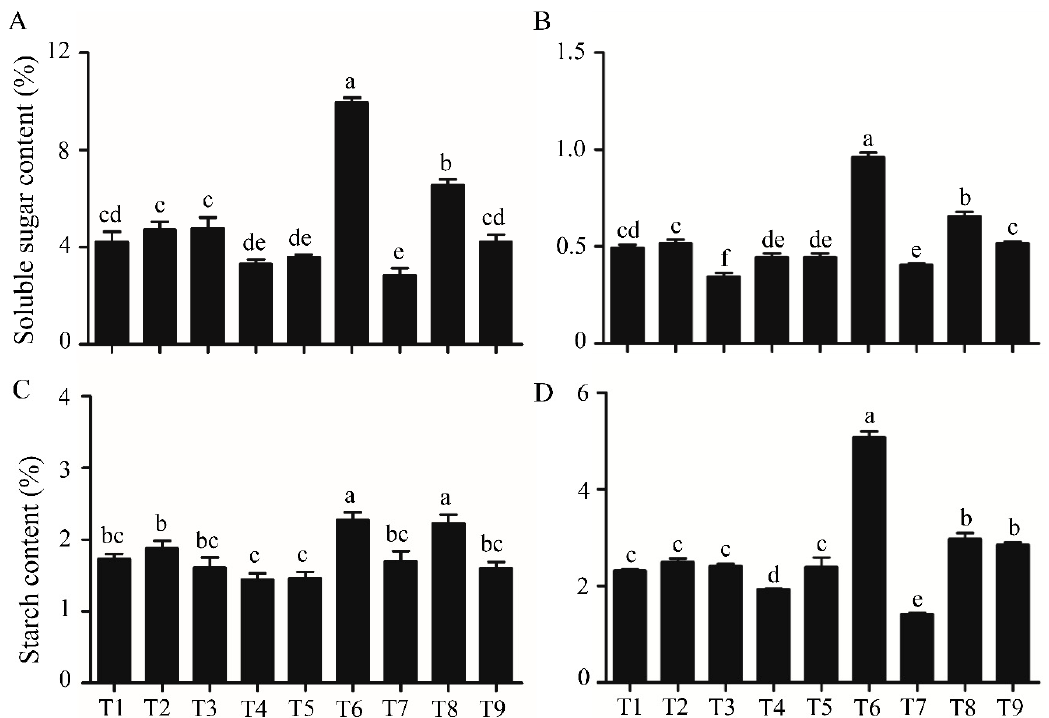
Figure 6. The sugar and starch contents in strawberry plants treated with different photoperiods, temperatures, GA 3 and 6-BA concentrations. ( A , B ) Soluble sugar contents in young leaves and crowns, respectively. ( C , D ) Starch contents in young leaves and crowns, respectively. Data are presented as the mean ± standard error ( n = 3). Lowercase letters indicate the significant difference according to Duncan’s multiple range test at a 0.05 level.